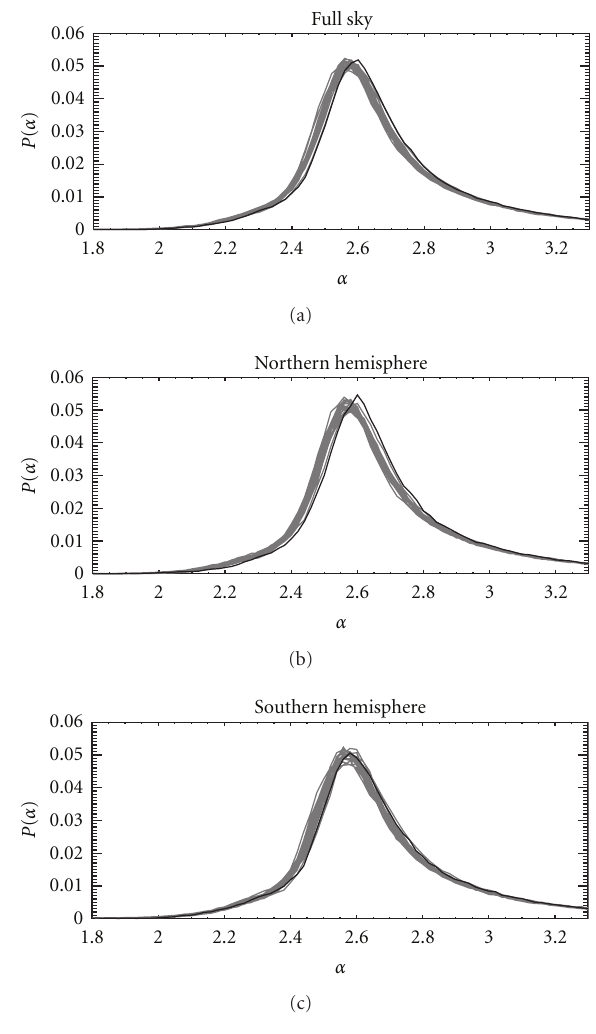
Figure 5: Probability density P ( α ) for the coadded WMAP 3-year data (black) and 20 simulations (grey) for r = 0 . 175 and the Kp0-